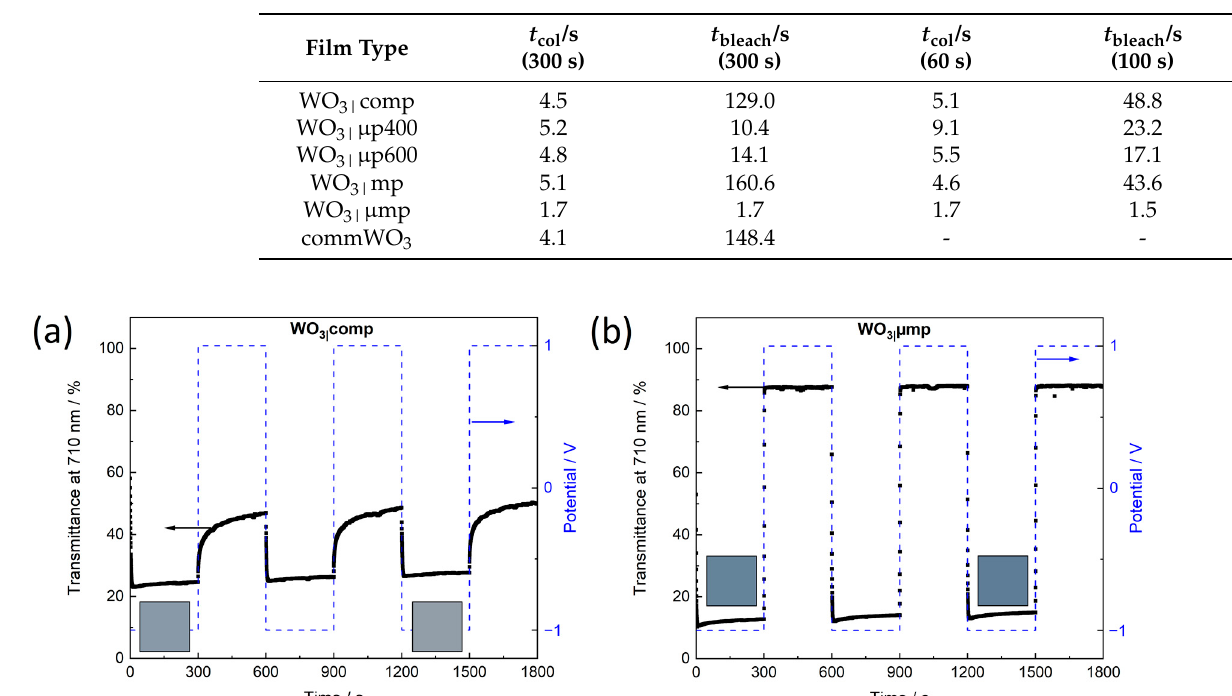
Table 9. Response times t col and t bleach of the different films obtained from CA measurements after prior opposite polarization for either 60 s, 100 s, or 300 s.